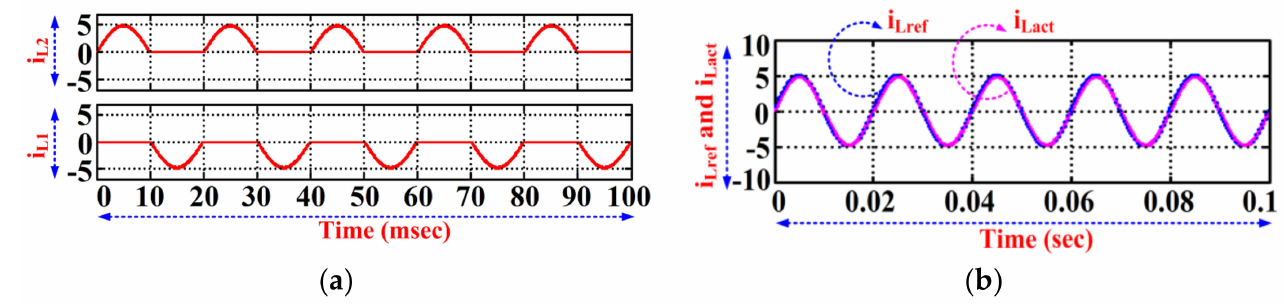
Figure 5. Simulation results. ( a ) Inductor current (i L1 and i L2 ). ( b ) I Lact (inverter current) tracks against I Lref .